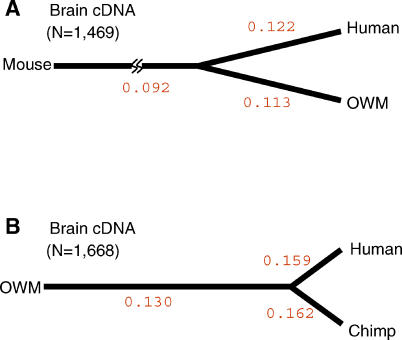
Lineage-Specific Ka/Ks Ratios for Brain-Expressed cDNAsThe Ka and Ks values along each branch were calculated by the PAML method [18], and the Ka/Ks ratios are given.(A) There were 1,469 brain-expressed genes common to human, OWM, and mouse.(B) There were 1,668 brain-expressed genes common to human, chimpanzee, and OWM.For details, see Tables 2 and 3.